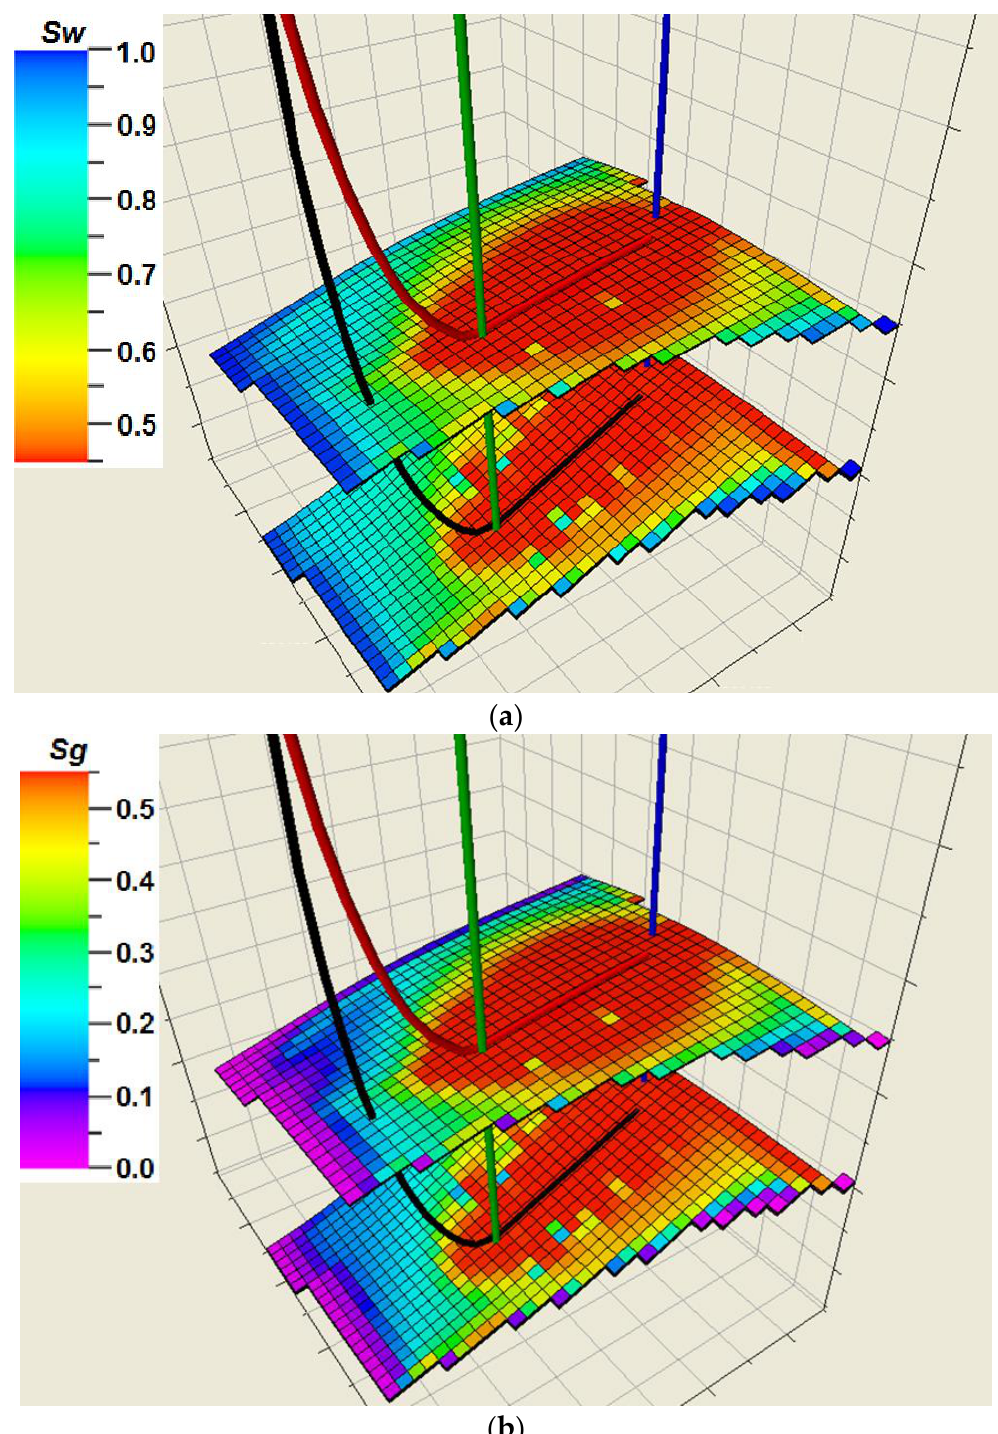
Figure 11. Changes in water saturation— Sw ( a ) and gaseous phase— Sg ( b ) in the fractures after 1 year of CO 2 injection.